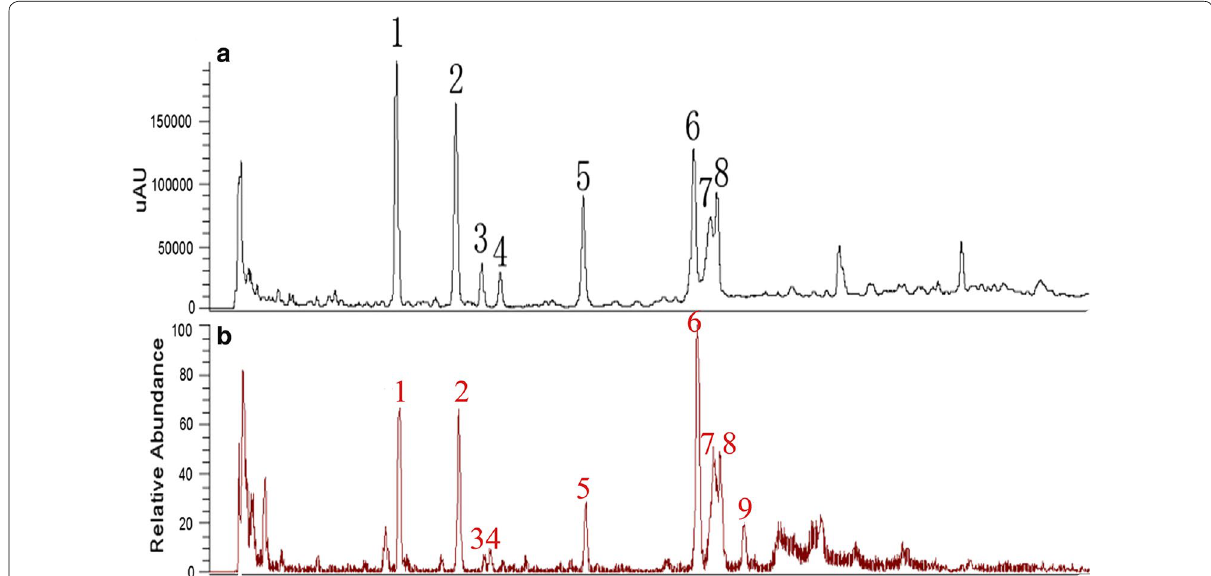
Fig. 2 UHPLC-UV chromatograms of Dendrobium officinale ( a ), The UHPLC-ESI/MS (TIC) fingerprint of Dendrobium officinale ( b )